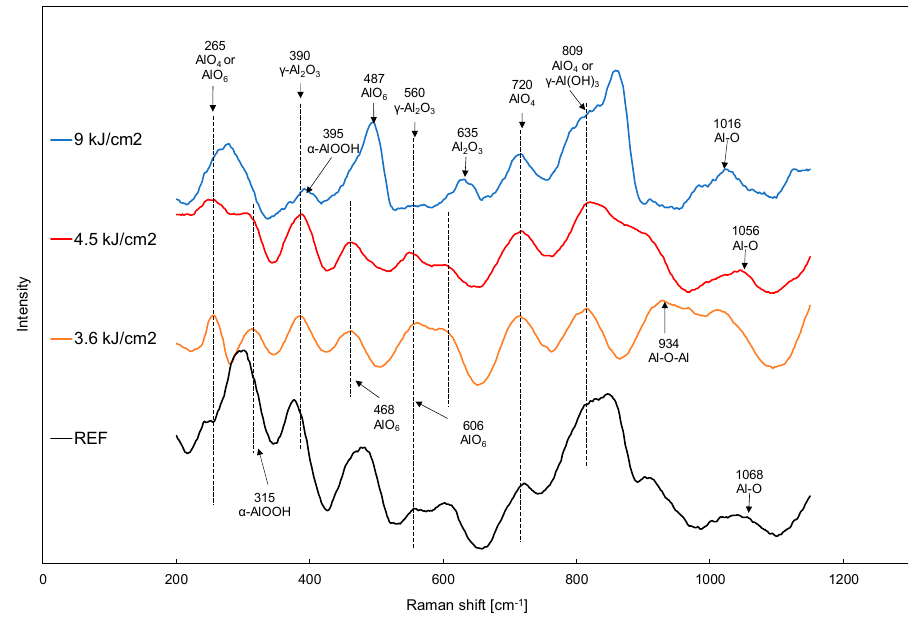
Figure 8. Raman spectra for reference and laser-treated aluminum 5754.